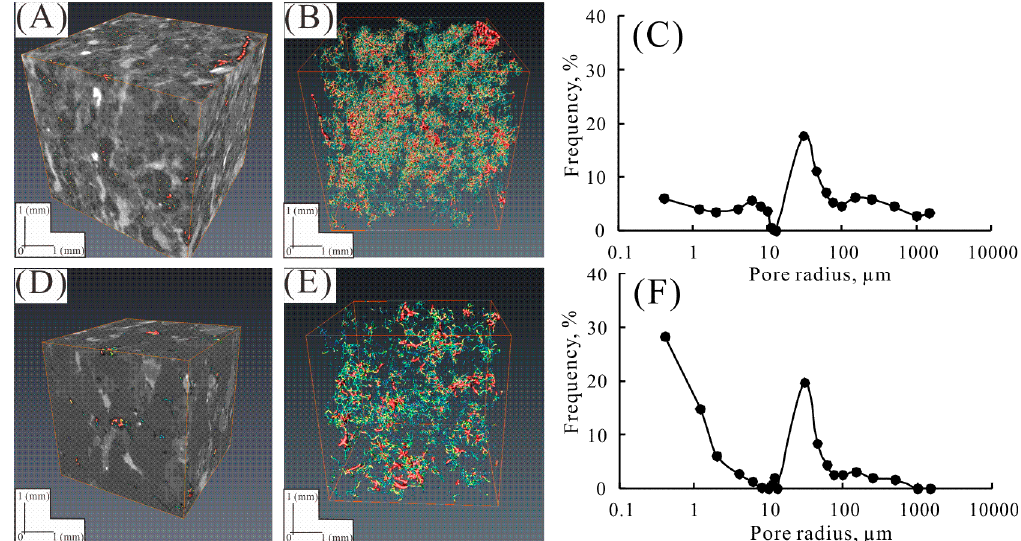
Figure 8. ( A , D ) Reconstructed 3D CT images and volume of ( B , E ) resolved pore-throat space and ( C , F ) micro-CT derived pore radius distribution of tight sandstone specimen of 11# and 12#, respectively. The pore-throat clusters are shown in different colors.